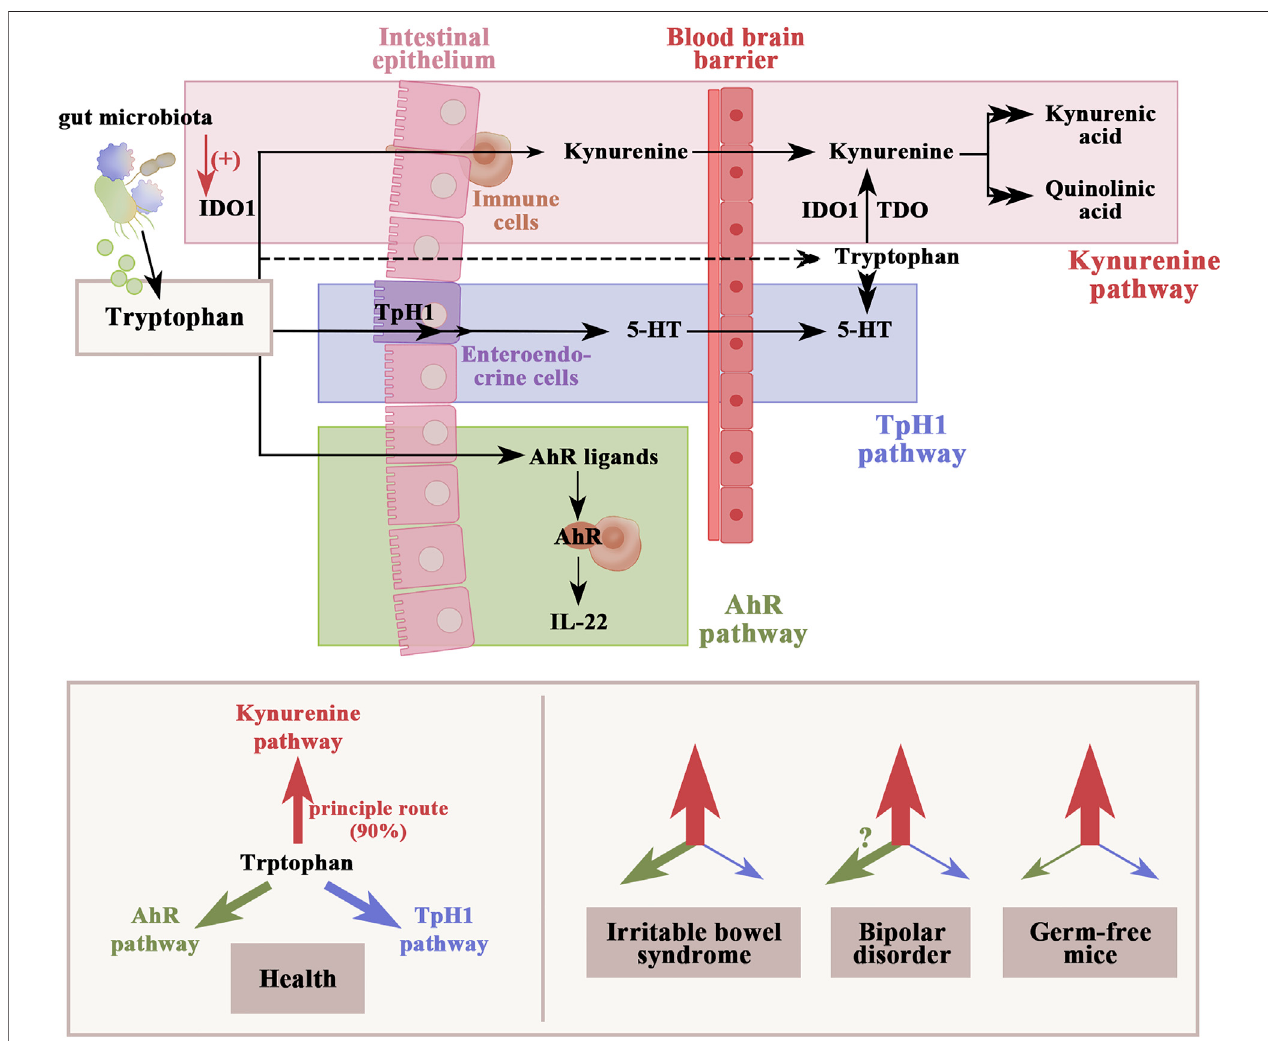
FIGURE 3 | Dietary tryptophan metabolism follows three major pathways in the gastrointestinal tract: 1) the kynurenine pathway via IDO1, which can be activated by gutmicrobial dysbiosis;2) production ofserotoninin enteroendocrinecells and indirect regulation oftryptophan availability underthe control ofgutmicrobiota; and 3) thedirectconversion toAhRligandsbygutmicrobiota.The fi gureshowsanaltered dynamicofthetryptophan metabolicpathwayinIBS,BD,andgerm-freemicebased on the available clinical data. Weights of arrows indicate the strength of pathway activation. IDO1, indoleamine 2,3-dioxygenase 1; TDO, tryptophan 2,3- dioxygenase; TpH1, tryptophan hydroxylase 1; AhR, aryl hydrocarbon receptor.